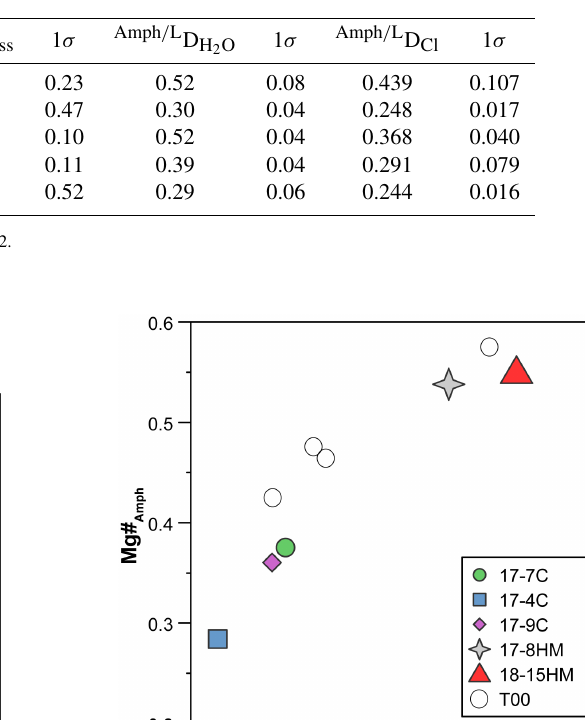
Table 4. Mean H 2 O contents in amphibole and glass determined by Raman spectroscopy in each experiment and calculated partition coeffi- cients for H 2 O and Cl ( Amph / L D H and Amph / L D Cl , respectively). 2 O